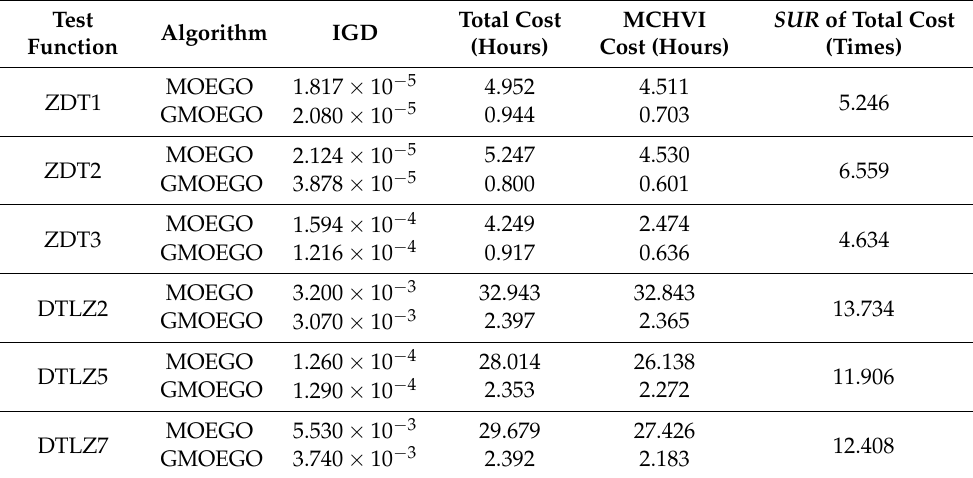
Table 2. Results of the test